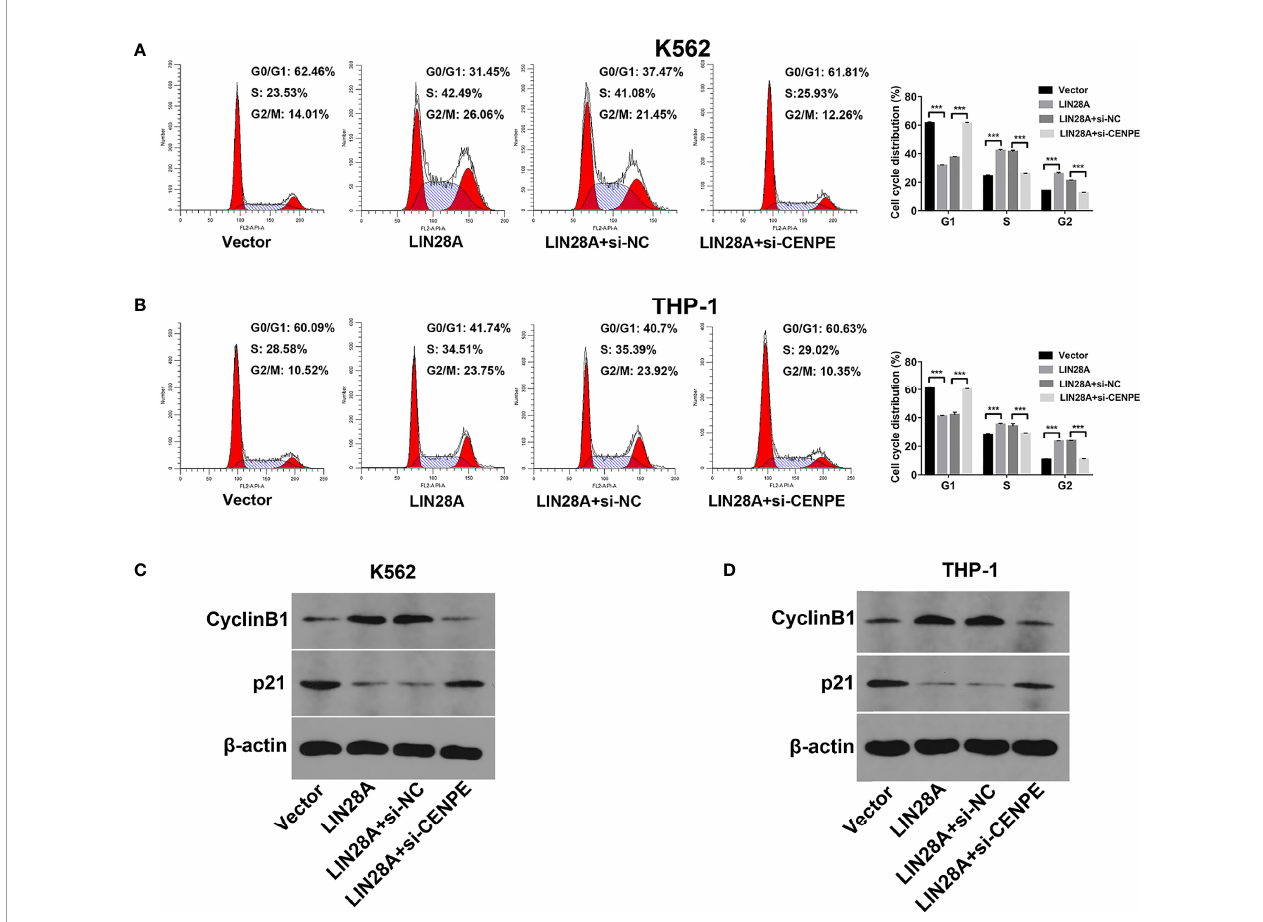
FIGURE 9 | LIN28A/CENPE inhibited the cell cycle progression in K562 and THP-1 cells. (A, B) After 48 h of transfection, cell cycle was measured by PI single- staining method in LIN28A overexpressed and CENPE interfered LIN28A overexpressed K562 and THP-1 cells. (C, D) After 48 h, Western blot analyzed the expression of cycle-related proteins Cyclin B1 and p21 in LIN28A overexpressed and CENPE interfered LIN28A overexpressed K562 and THP-1 cells. *** p <